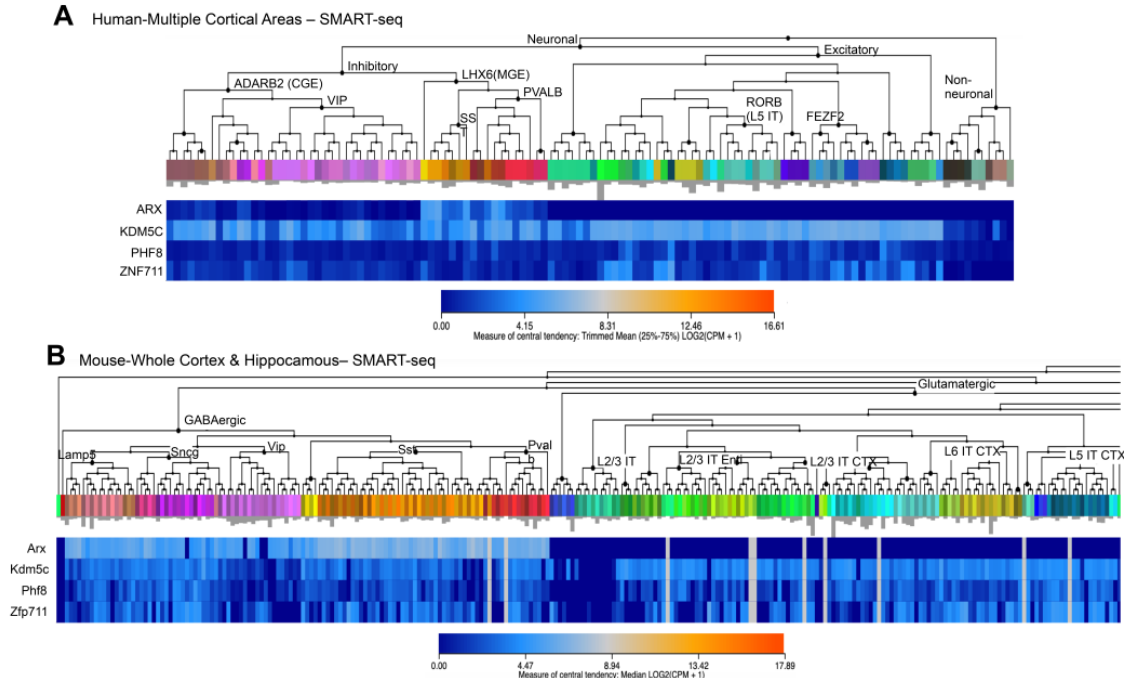
Figure 7. Heatmaps showing the expression profiles of KDM5C/Kdm5c and its regulatory genes ARX/Arx , PHF8/Phf8 , and ZNF711/Zfp711 . Data were obtained from Allen Brain Atlas/Transcriptomics Explorer in human ( A ) and mouse ( B ). Original images can be accessed freely at https://celltypes.brain-map.org/rnaseq/ (accessed on 10 July